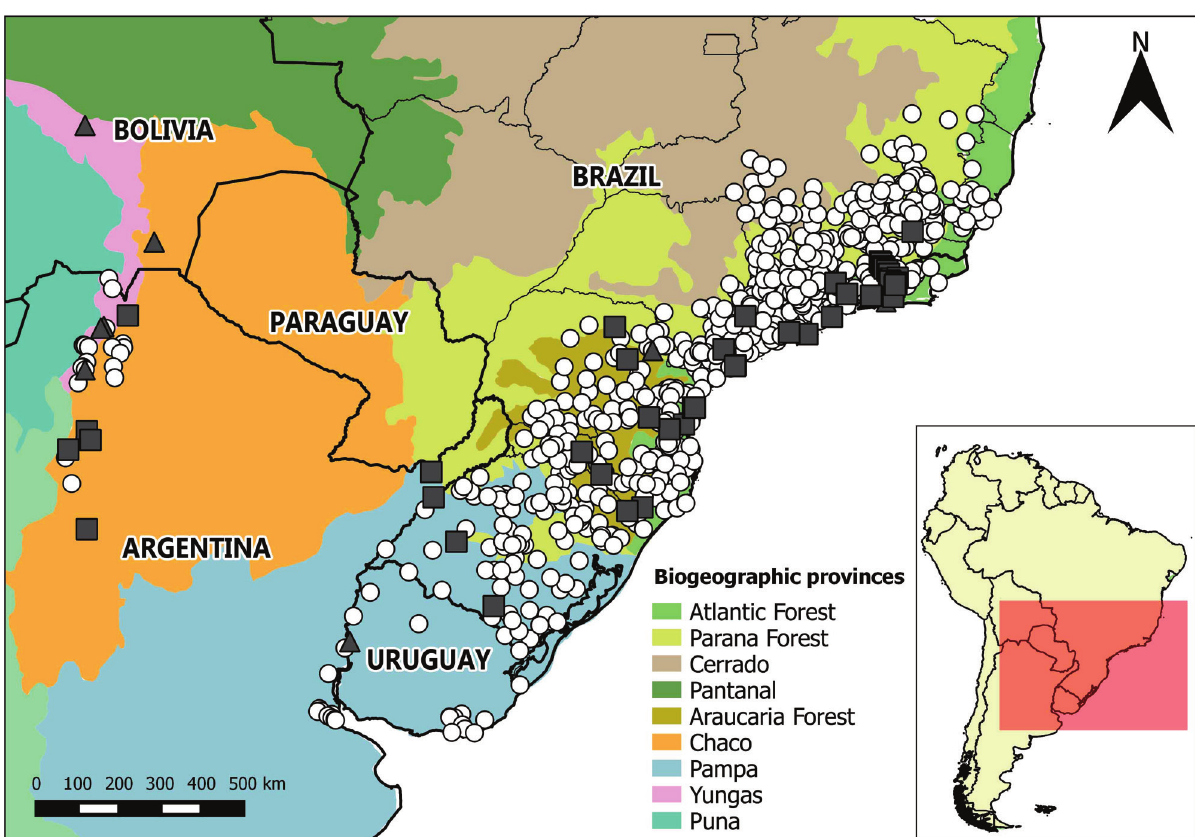
Figure 1. Distribution of Penelope obscura . Black squares: specimens analyzed personally; Black triangles: specimens analyzed by photo- graphs; White circles: living individuals